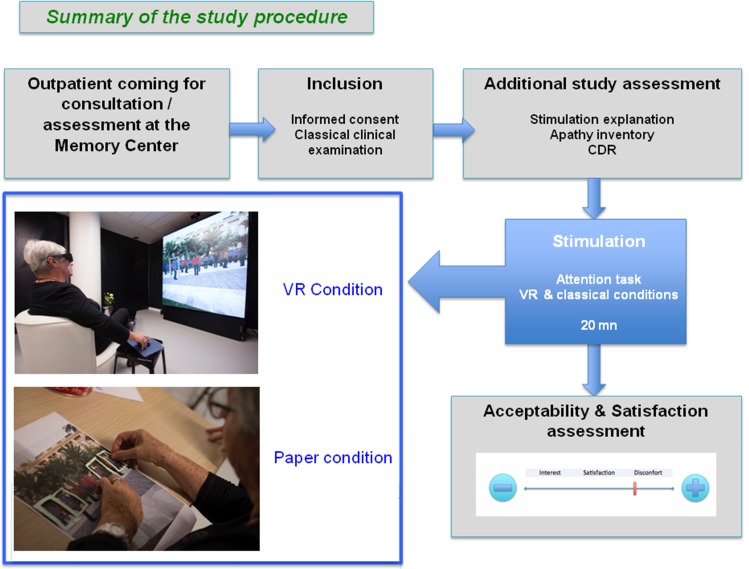
Summary of the study procedure.